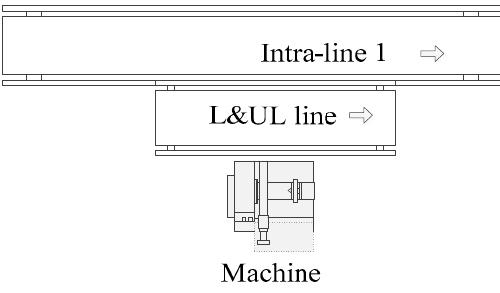
Figure 3. Add one short ARB segment (L&UL line) in front of each machine.